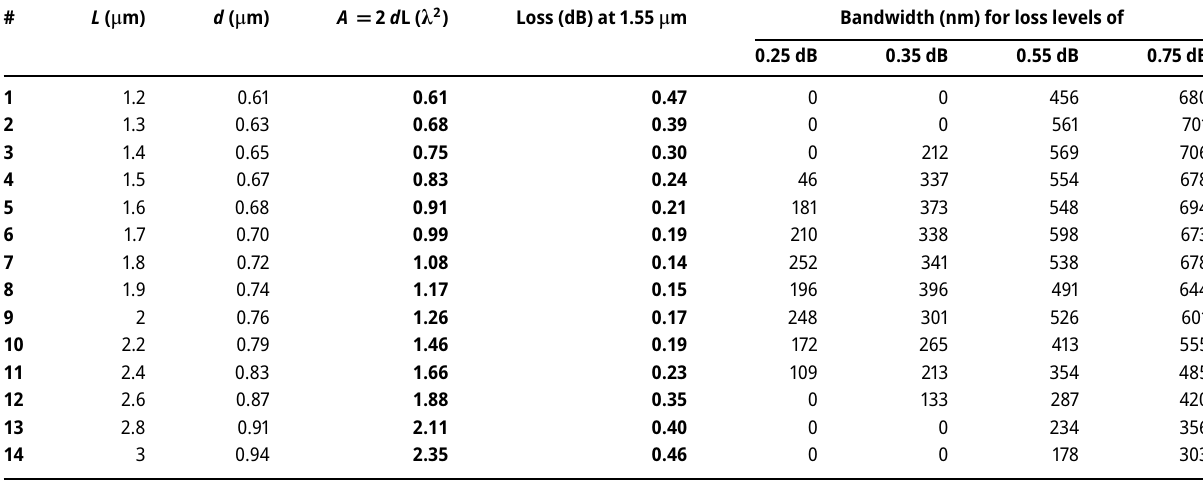
Figure 8: Performance of the equal power Y-junctions. (a) The geometries ( d and L ) of the inverse-designed Y-junctions (blue open circles). The solid linear line { d = 0 . 185 L + 0 . 39 } is the fit to the blue circles. (b) The FDTD simulated loss as a function of geometrical parameters (circles). The solid line represents the fourth order polynomial fit for the circles. In this figure top and bottom horizontal axes represent d and L , respectively. The parameters d and L are linearly related [see (a)]. (c) The losses as functions of wavelength for devices with L = 1.4 μ m (blue), and 1.8 μ m (red). (d) Bandwidth as a function of loss levels for the two devices in (c). Table 4: The performances of the representative devices with sub-0.5 dB losses a function of geometrical parameters and